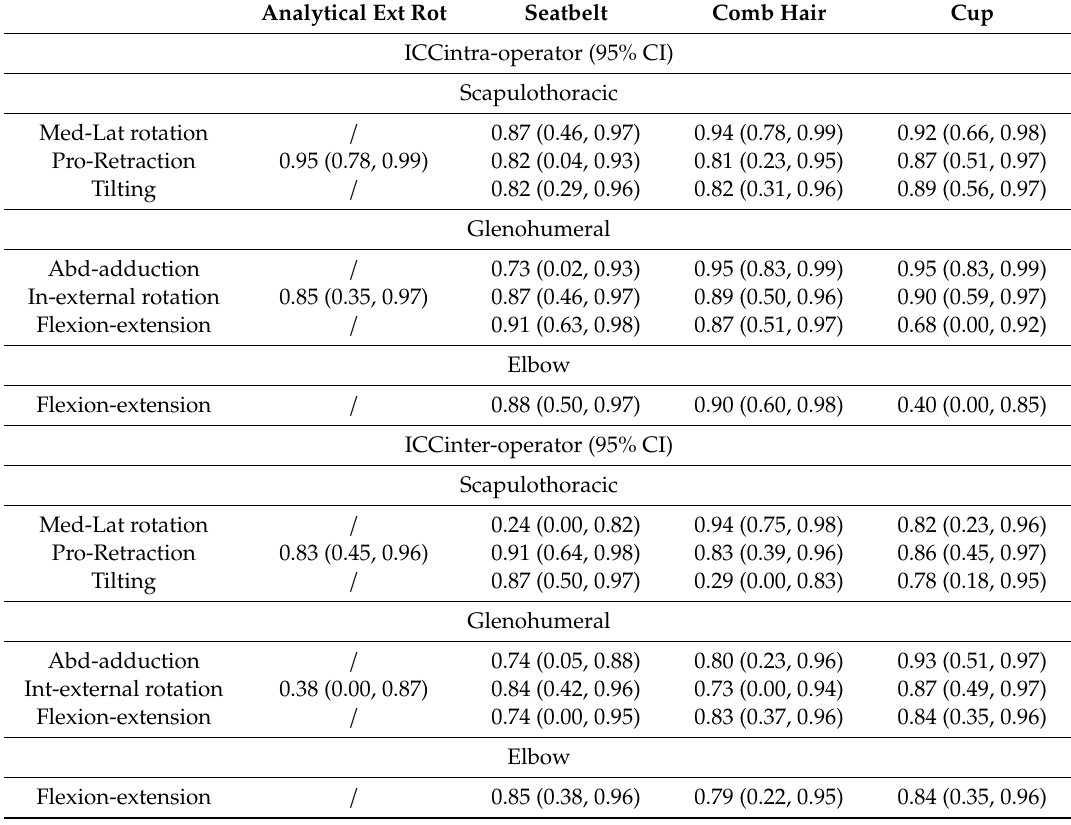
Table 5. Intraclass correlation coe ffi cients for intra- and inter-operator